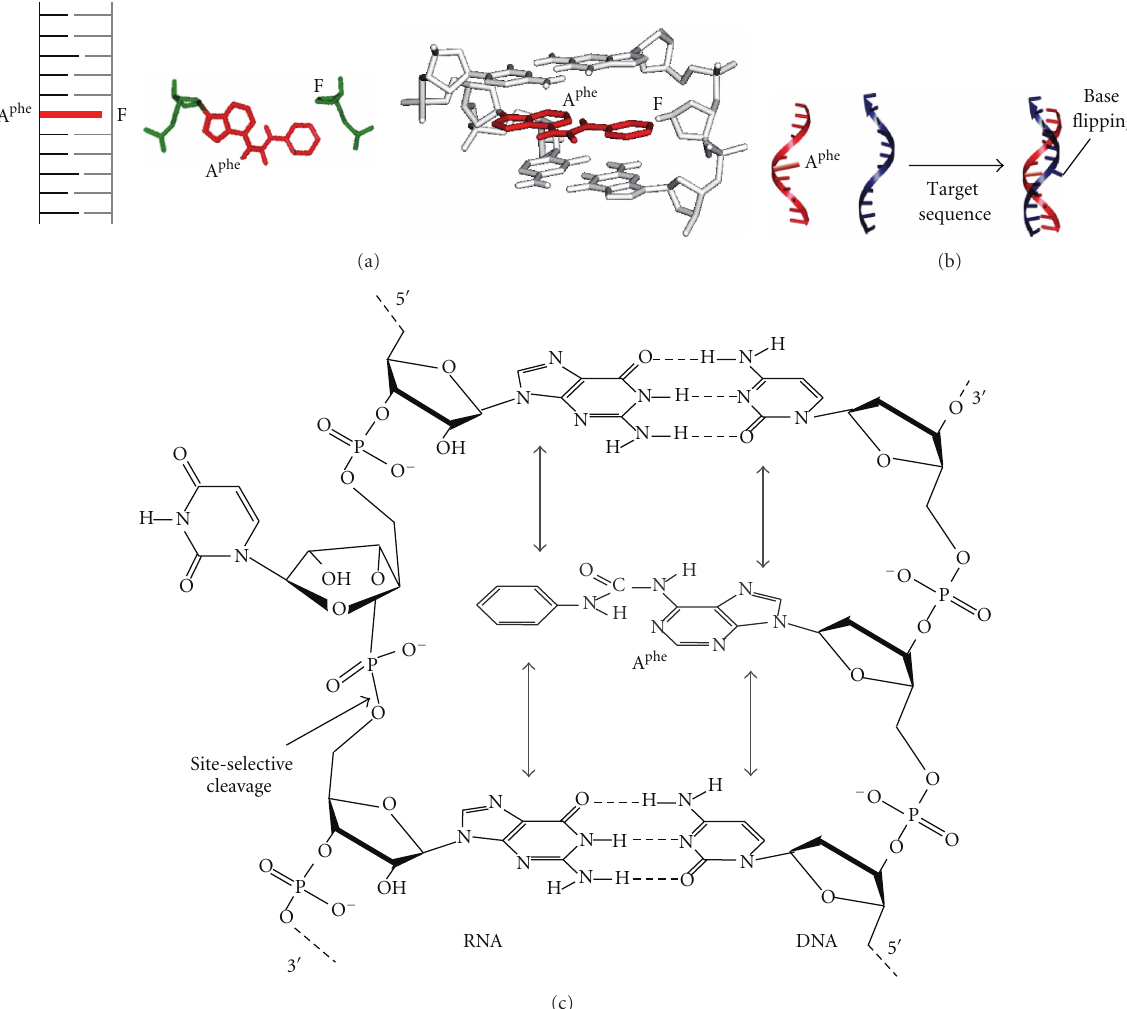
Figure 6: (a) The stacking conformation of A phe opposite an abasic site F in the center of a DNA duplex. (b) Hybridization of the DNA strand bearing A phe with a complementary target strand, followed by the formation of the flipped-out conformation. (c) The base flipping conformation induced by A phe in an RNA/DNA duplex. The hybridized RNA strand is cleaved site-selectively at the 5 (cid:2) -side of the phosphodiester bond of the flipped-out